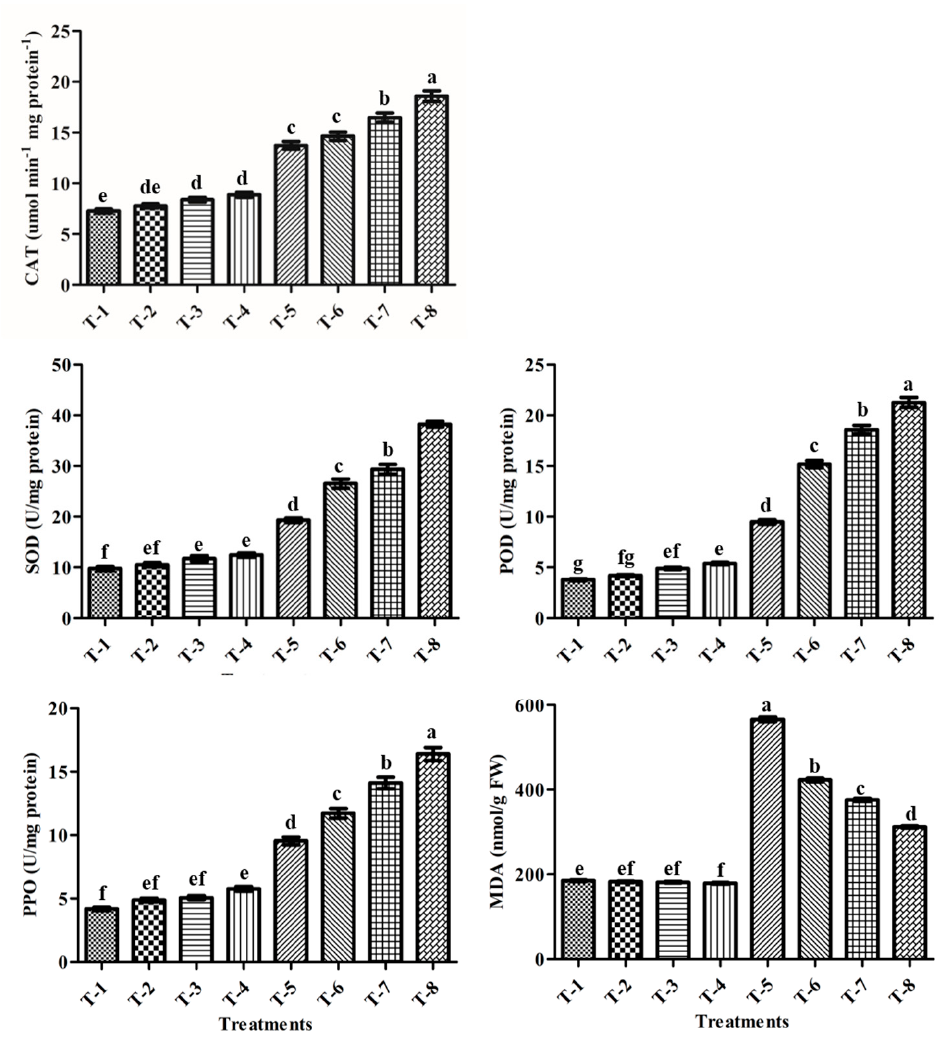
Figure 7. Effect of salt-tolerant PGPR ASN-1 and SNP on antioxidant enzyme activity. T-1: Un-inoculated control; T-2: SNP; T-3: PGPR ASN-1; T-4: PGPR ASN-1 + SNP; T-5: NaCl (200 mM); T-6: NaCl + SNP; T-7: NaCl + PGPR ASN-1; T-8: NaCl + PGPR ASN-1 + SNP. The mean ± SE, n = 3 is represented. Letters on each bar represent significant variances ( p < 0.05) after the DMRT test.